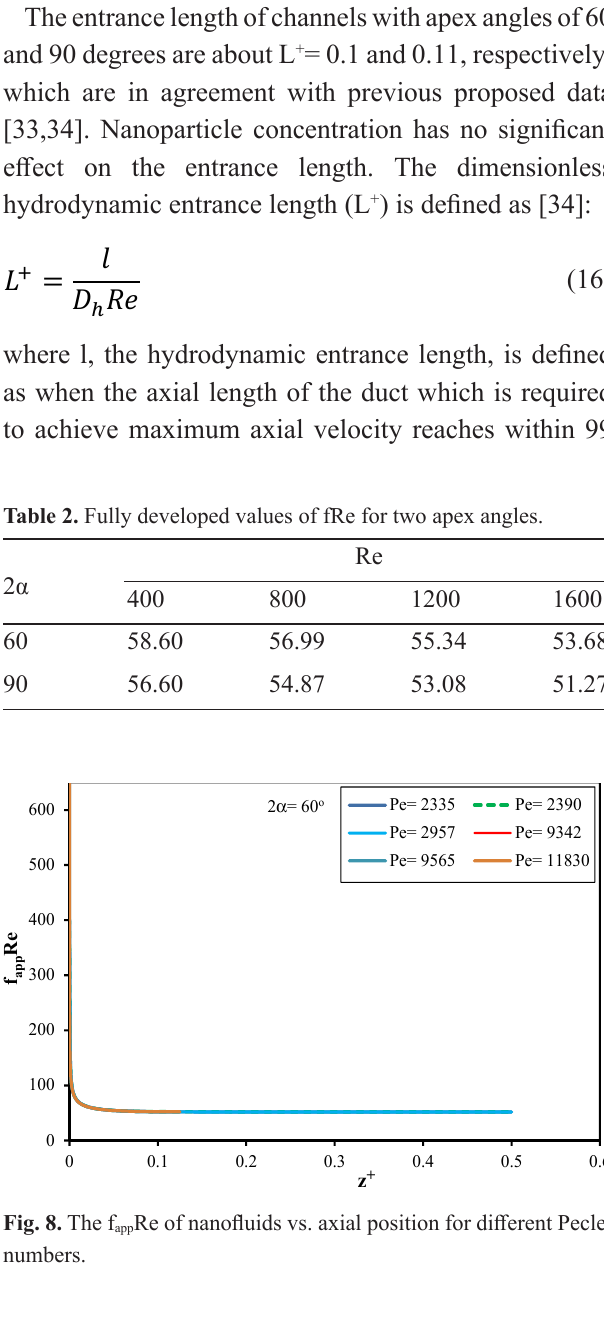
Fig. 7. Average Nusselt number vs. nanoparticle concentration for channels with different apex angles.